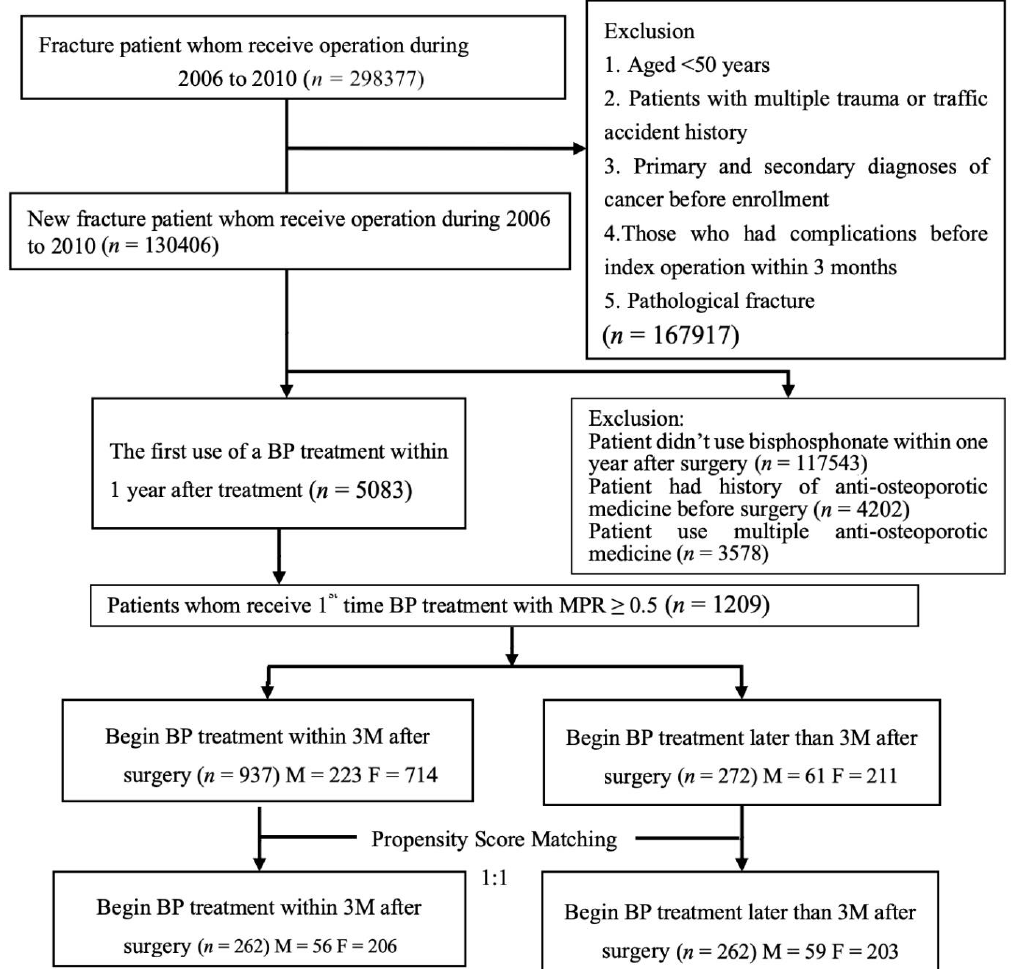
Figure 1. Study protocol. BP: bisphosphonate (alendronate); MPR: medication possession ratio. Table 1. Clinicodemographic characteristics of the study population.